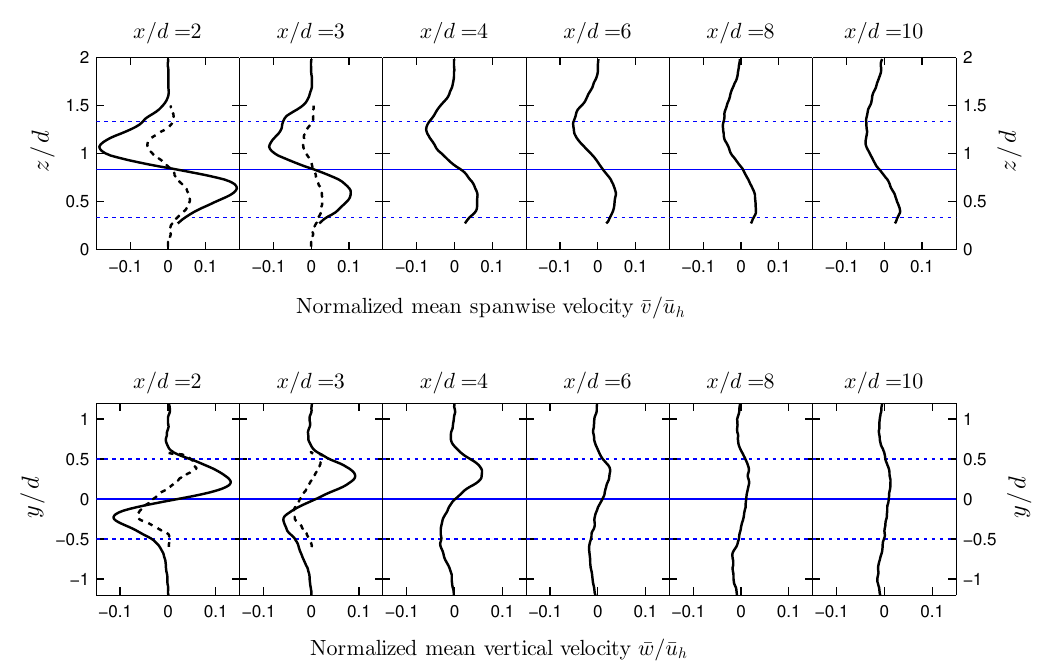
Figure 6. Vertical profiles of the normalized spanwise velocity ( top ) and lateral profiles of the normalized vertical velocity ( bottom ) through the hub level at different downstream locations. Solid black lines: new miniature turbine, and dashed black lines: Zhang et al. [11]. Blue solid lines and blue dashed lines represent the rotor axis and the tip positions,